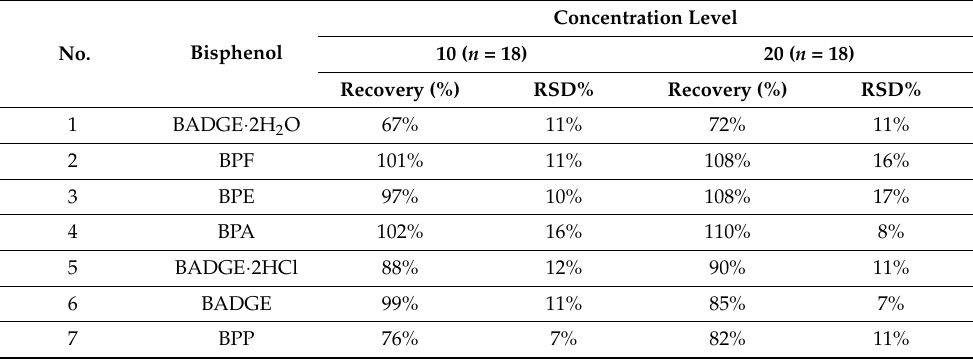
Table 2. The mean recovery values and relative standard deviations for all 7 studied analytes obtained during validation of the procedure ( n = 18, n = 6 per day).